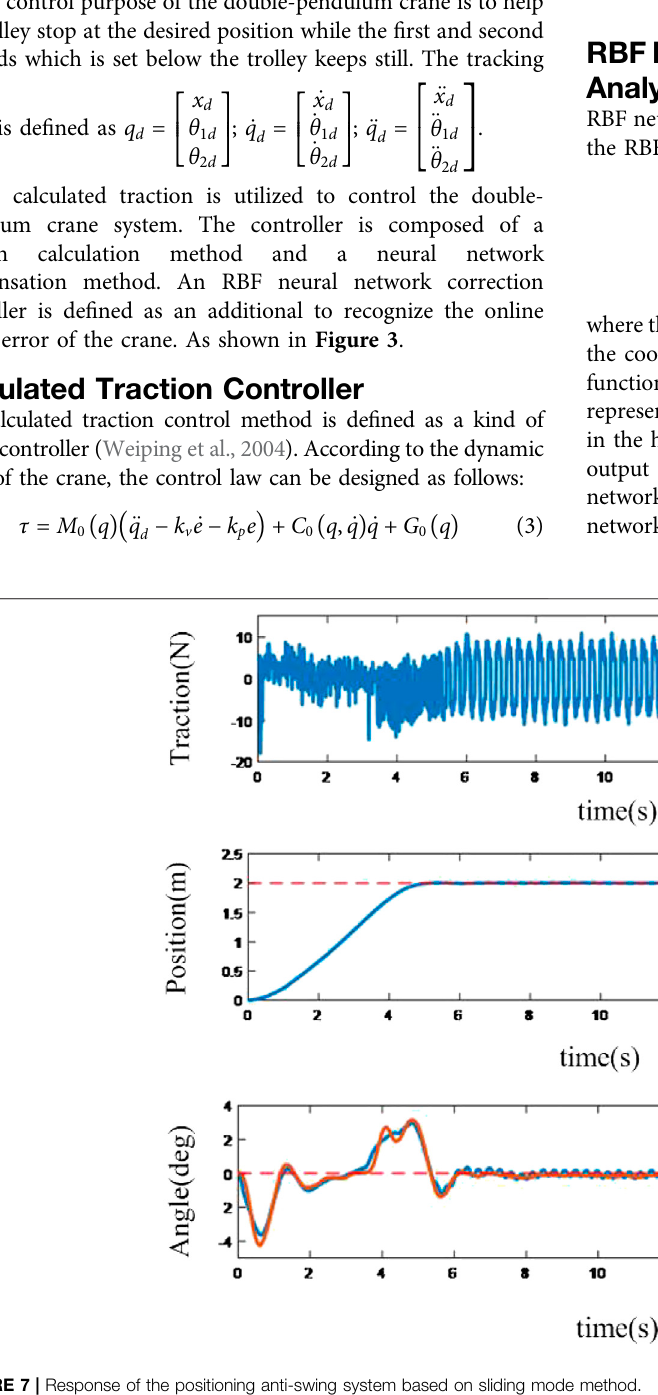
Frontiers in Robotics and AI |